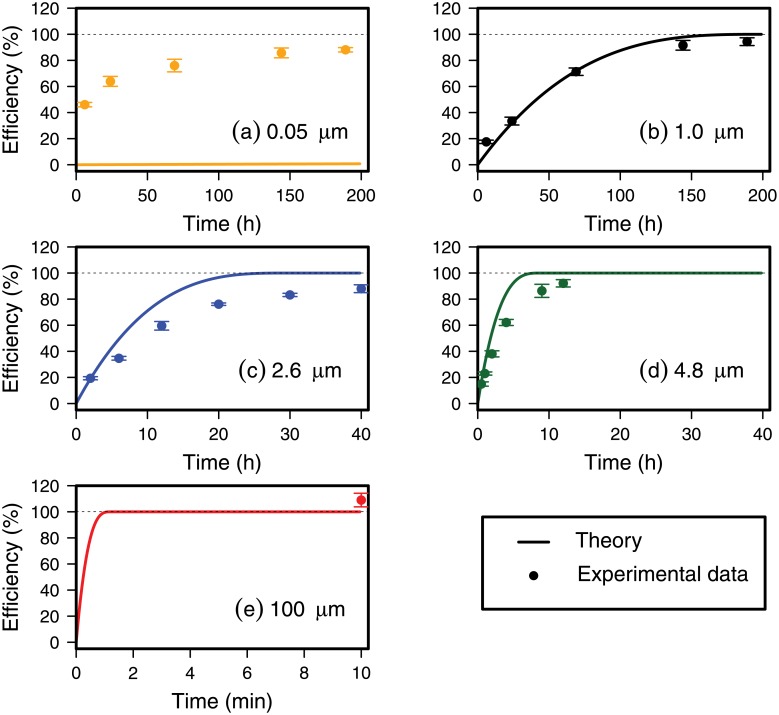
Extraction efficiency for flotation of nano- and microbeads.Extraction efficiency of different size polystyrene beads as a function of time. Beads were suspended on ZnCl2 solution in a separatory funnel. Solid lines are theoretical extraction efficiencies calculated with Eq 5, symbols are experimental data, and error bars are ± one standard deviation. Note the different time unit in plot (e).